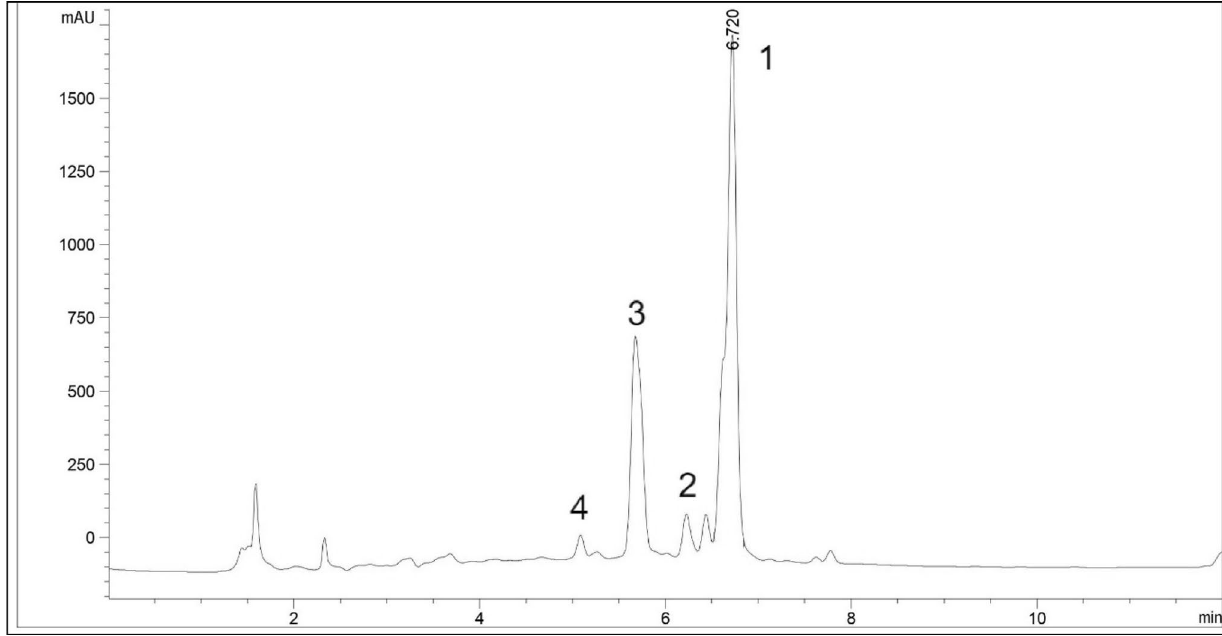
Figure 4. HPLC chromatogram of C. caudatus extract at 260 nm. The peak as follow: 1, quercitrin; 2 quercetin glycoside; 3, unknown peak; 4,